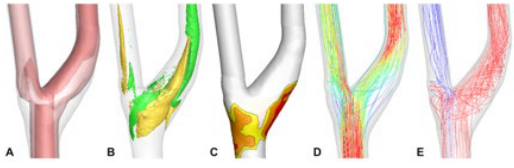
Figure 2 | Different representations of the same computational dataset: (A) Isosurfaces of speed; (B) Isosurfaces of helicity, coloured to distinguish counter- rotating flow streams; (C) Contours of wall shear stress, highlighting regions of low shear; (D) streamlines at peak systole, coloured according to speed; (E) pathlines of particles released at peak systole.